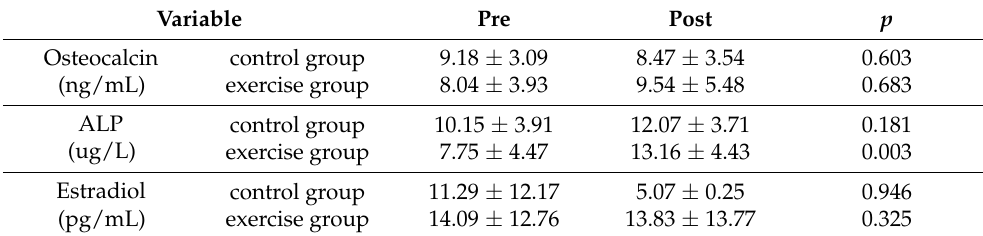
Table 3. Changes in osteocalcin after 6-month compound